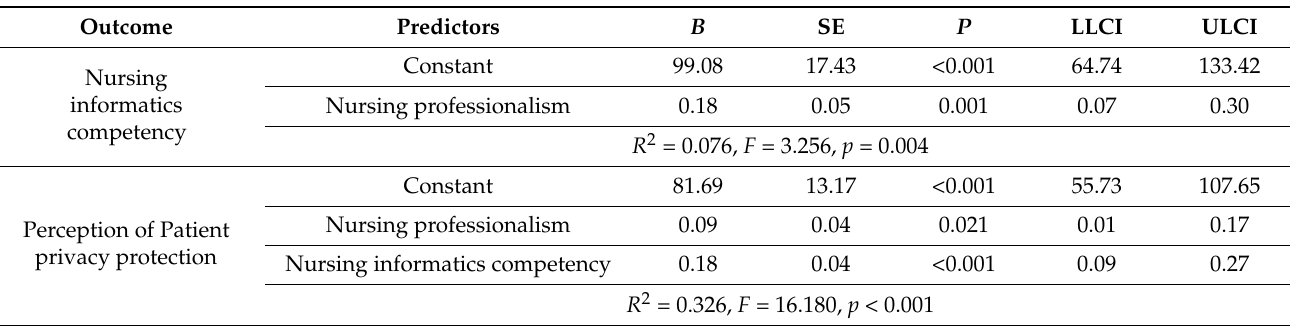
Table 3. Mediating effect of nursing informatics competency on the relationship between nursing professionalism and perception of patient privacy protection.